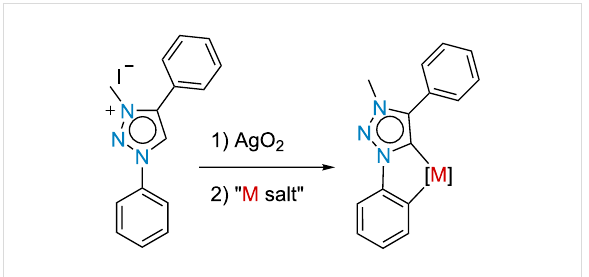
mesoionic carbenes (MICs) [18-22], particularly the fact that 1,4-diphenyl-substituted 1,2,3-triazol-5-ylideneruthenium(II), iridium(III) and rhodium(III) complexes underwent spontane- ous, chemoselective cyclometalation via C–H bond activation of the N-bound phenyl group (see Figure 2) [19].